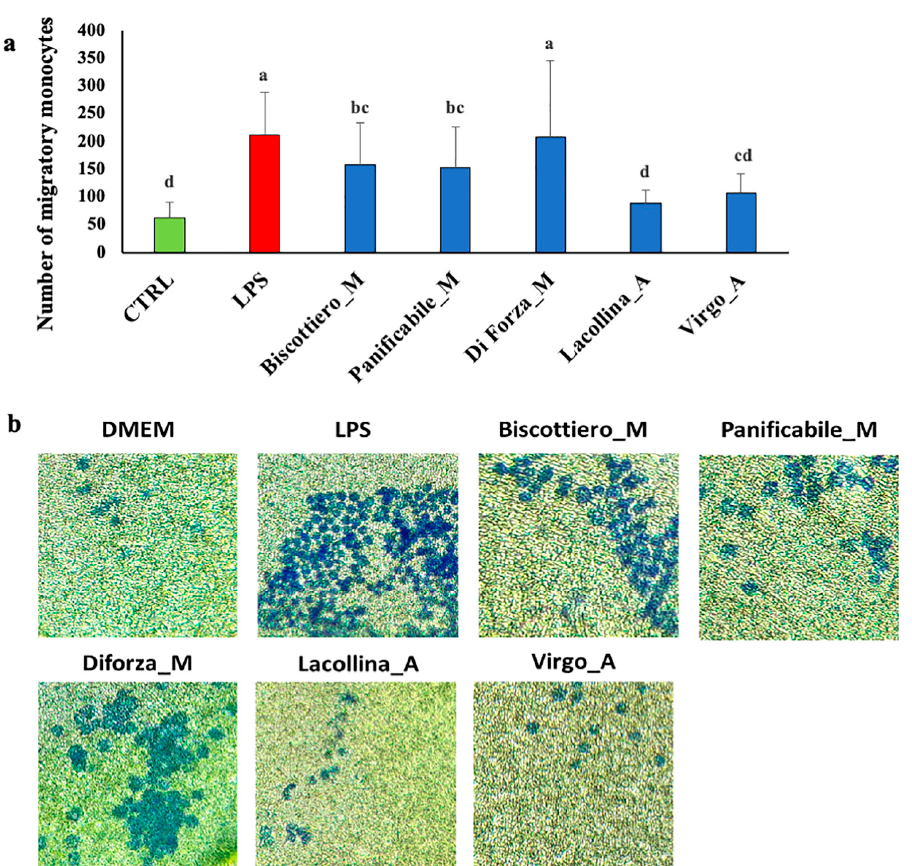
Figure 5. ( a ) Number of migratory U937 monocytes and ( b ) phase contrast microscopy (40× magnification) images of cells stained with toluidine blue thiazine dye after a 24 h exposure of Caco-2 cells in co-culture to either 1 µg/mL LPS or 40 µg/mL total protein (albumins + globulins + gliadins + glutenins) from three commercially available modern wheat mixes (denoted by M) and two heritage wheat mixes (denoted by A). The designation of the letters a, b, c, and d represents significant differences between varieties as determined by one-way ANOVA at the 95% confidence level ( p ≤ 0.05). Interleukin-8 (IL-8) is a stress-responsive pro-inflammatory chemokine, facilitating an early innate immune response [20]. Given that IL-8 release from epithelial cells is strongly chemotactic for all known types of migratory immune cells [20] and has been documented to increase in gliadin-treated Caco-2/TC7 cells [21], IL-8 in the cell medium was measured. LPS-treated Caco-2 cells induced the increase in IL-8, which was released into the medium (Figure 6a). Protein extracts of Diforza_M and Biscottiero_M induced equivalent IL-8 levels to that of LPS. Protein extracts of Panificabile_M induced signifi- cantly lower levels of IL-8 compared to the former modern flour proteins, although there was a high degree of variation (Figure 6a). Virgo_A-treated Caco-2 cell lines showed IL-8 levels that were not significantly different from the control, indicating that wheat protein from this landrace flour mix did not induce IL-8 production. In contrast to the Virgo_A-